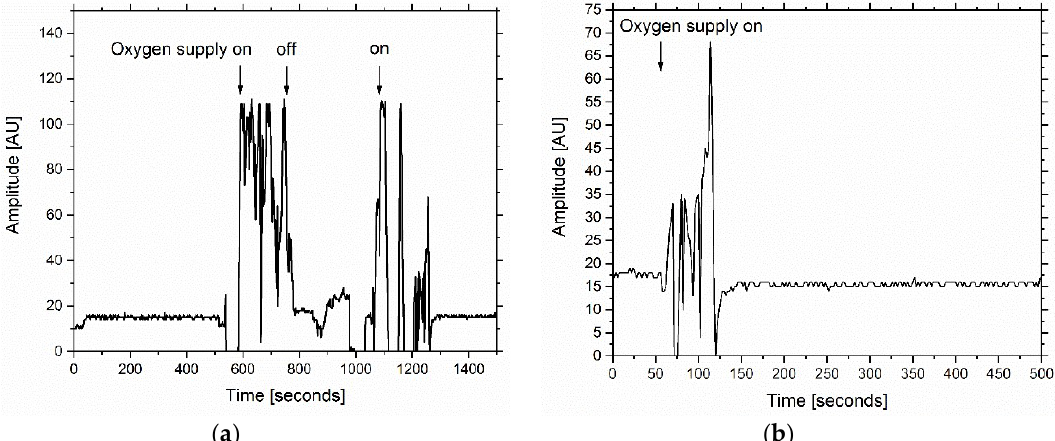
Figure 8. A 1% ( w / v ) agarose gel including the bacterial cells was casted with a final cell density of OD 600 = 5. The whole sensor set-up was then placed in a closed glass vessel on a platform with humidified 2,4-DNT underneath (distance = 5 cm). The vessel was closed and incubated for 3 h. Afterwards molecular oxygen was introduced into the sensor set-up and the resulting bioluminescence response was measured. ( a ) The same experiment was repeated, however no 2,4-DNT was added to the glass vessel. ( b ).